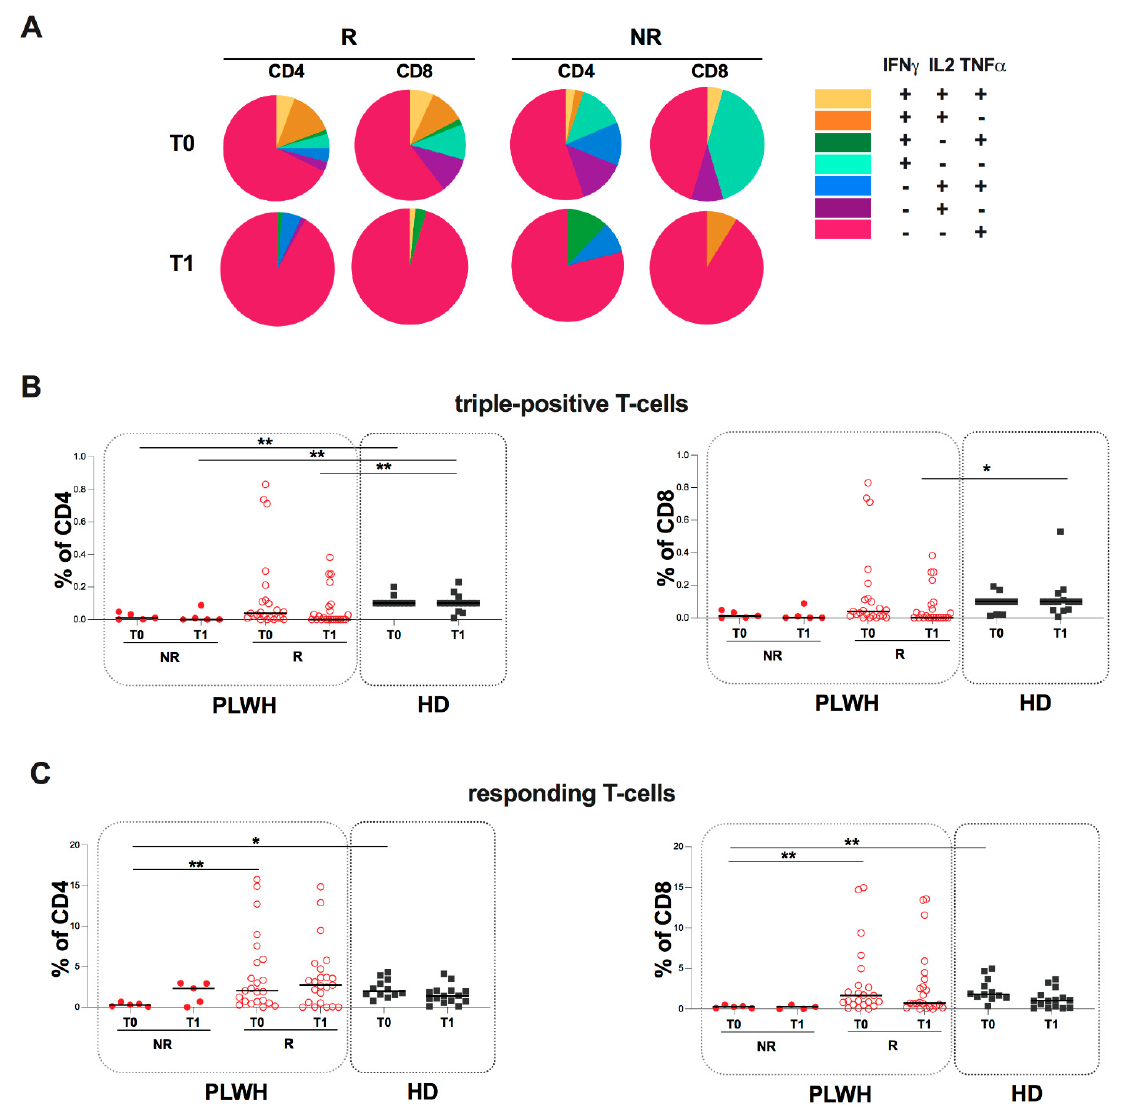
Figure 3. Evaluation of S − specific humoral and T − cell response in PLWH stratified according to humoral response into NR and R at T0 and T1. ( A ) Pie charts representing multifunctional cytokine analysis of specific CD4 and CD8 T − cells in PLWH stratified according to humoral response. ( B ) Percentage of triple − positive T − cells in PLWH stratified according to humoral response. The differences between NR and R subgroups were evaluated using the nonparametric Mann − Whitney test. Both NR and R subgroups were compared to HD using the nonparametric Kruskal − Wallis test with Dunn’s post − test. Data are shown as median (lines). ( C ) Percentage of responding T − cells in PLWH stratified according to humoral response. The differences between NR and R subgroups were evaluated using the nonparametric Mann − Whitney test. Both subgroups were compared to HD using the nonparametric Kruskal − Wallis test with Dunn’s post − test. Data are shown as median (lines). Statistical significance (p) is reported in the graphics. ** p < 0.01; * p < 0.05.